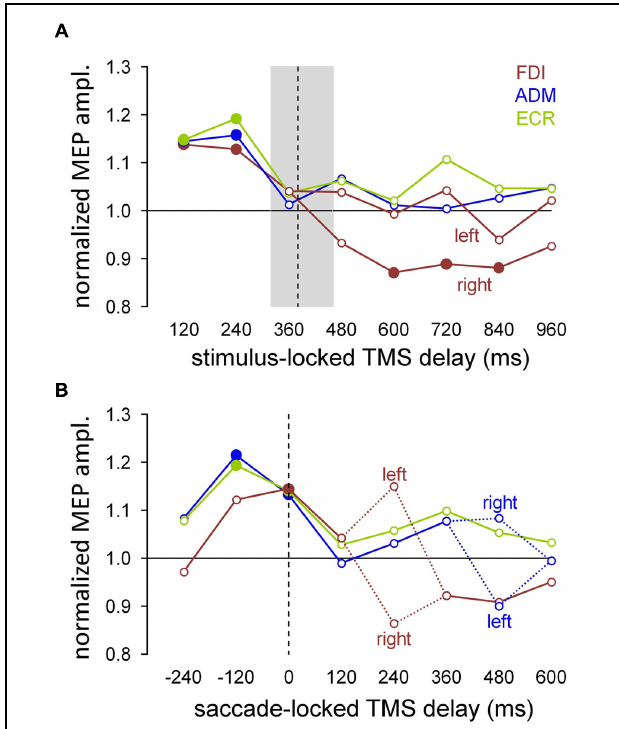
FIGURE 5 | For each muscle, modulation of the mean amplitude of MEPs recorded during the ‘go’ trials. Filled symbols denote a statistically significant difference from the baseline (one-sample t -test; P < 0.05). (A) Stimulus-locked analysis performed by averaging the MEP amplitudes for each TMS delay with respect to the visual stimulus. In the FDI muscle, the responses were separately averaged as a function of the target side for TMS delays longer than 360 ms. The median value (vertical dashed line) and the interquartile range (gray shade) of the saccade latencies are also shown. (B) Saccade-locked analysis performed by aligning the occurrence of TMS to saccade onset. Mean MEP amplitudes were computed after grouping the TMS delays with respect to the beginning of the eye response, in equally spaced bins of 120 ms. Figures drawn along the X -axis represent the bin central values used for the averaging procedure. Negative values indicate that the MEPs were elicited before the ocular response. Dashed lines connect the mean values for the left and right visual stimuli, for the bins that yielded a statistically significant difference in MEP amplitude relative to the side of target appearance. Y -axis values higher than unity indicate MEP amplitudes larger than